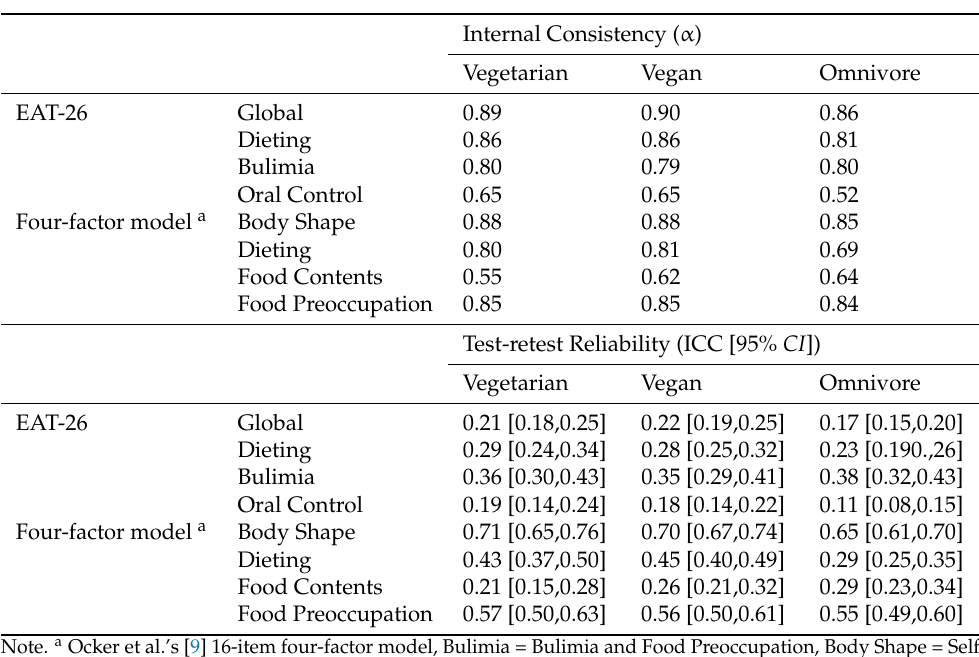
Table 3. Internal consistency and test-retest reliability of the Eating Attitudes Test (EAT) in vegetarians, vegans, and